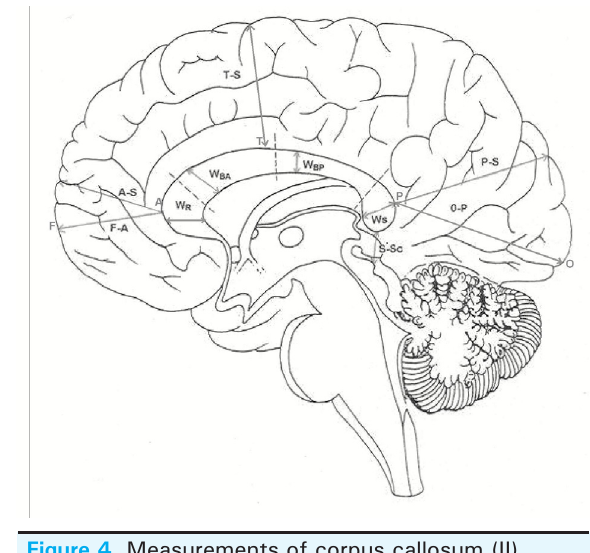
figure 4. Measurements of corpus callosum